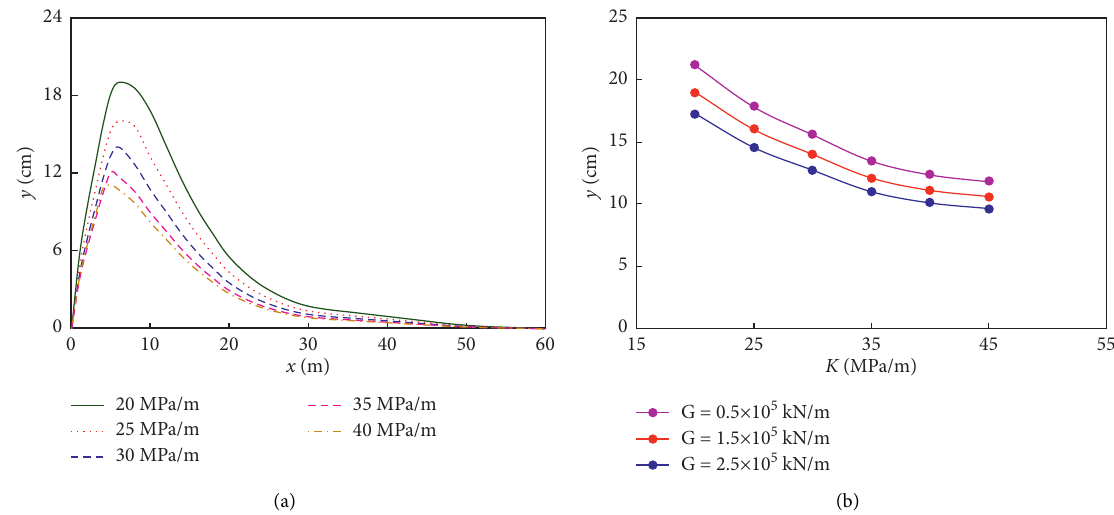
Figure 8: Influence of coefficient of subgrade modulus on the segment uplift: (a) variation of segment uplift under the different values of K ; (b) relationship between the maximum segment uplift and K